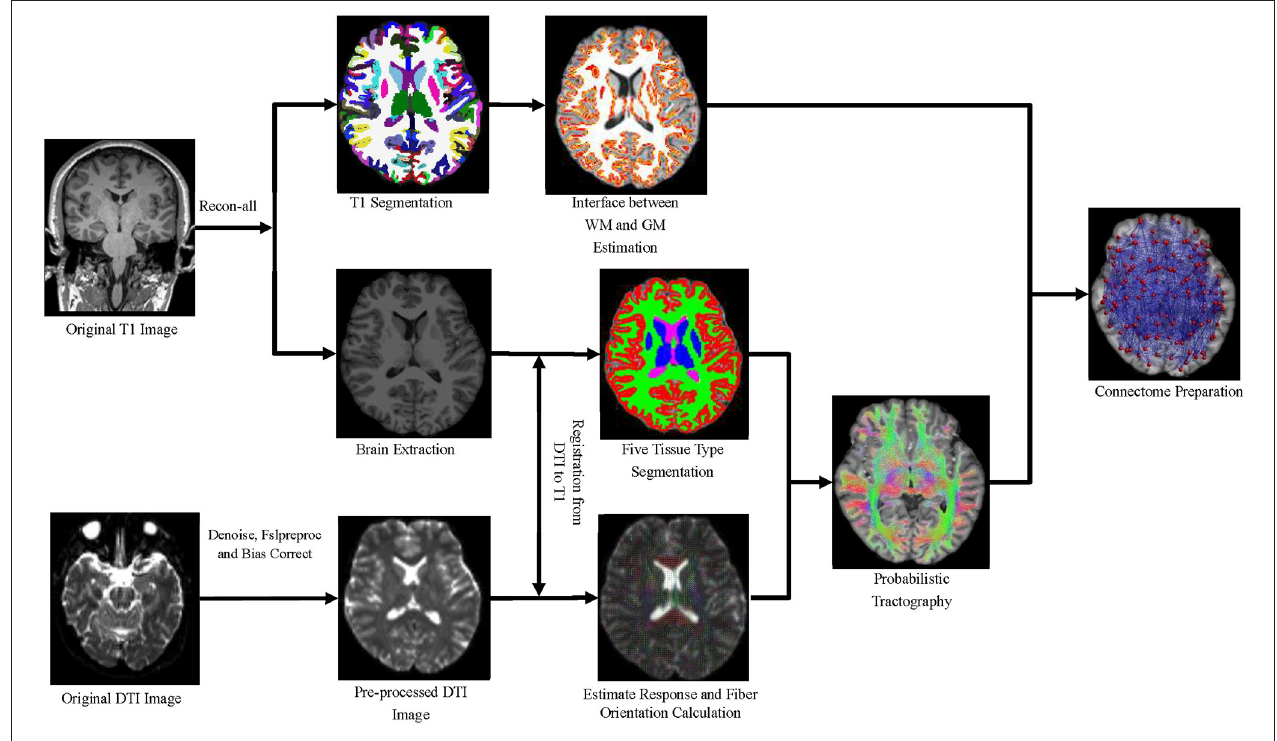
FIGURE 2 | A flowchart of white matter network